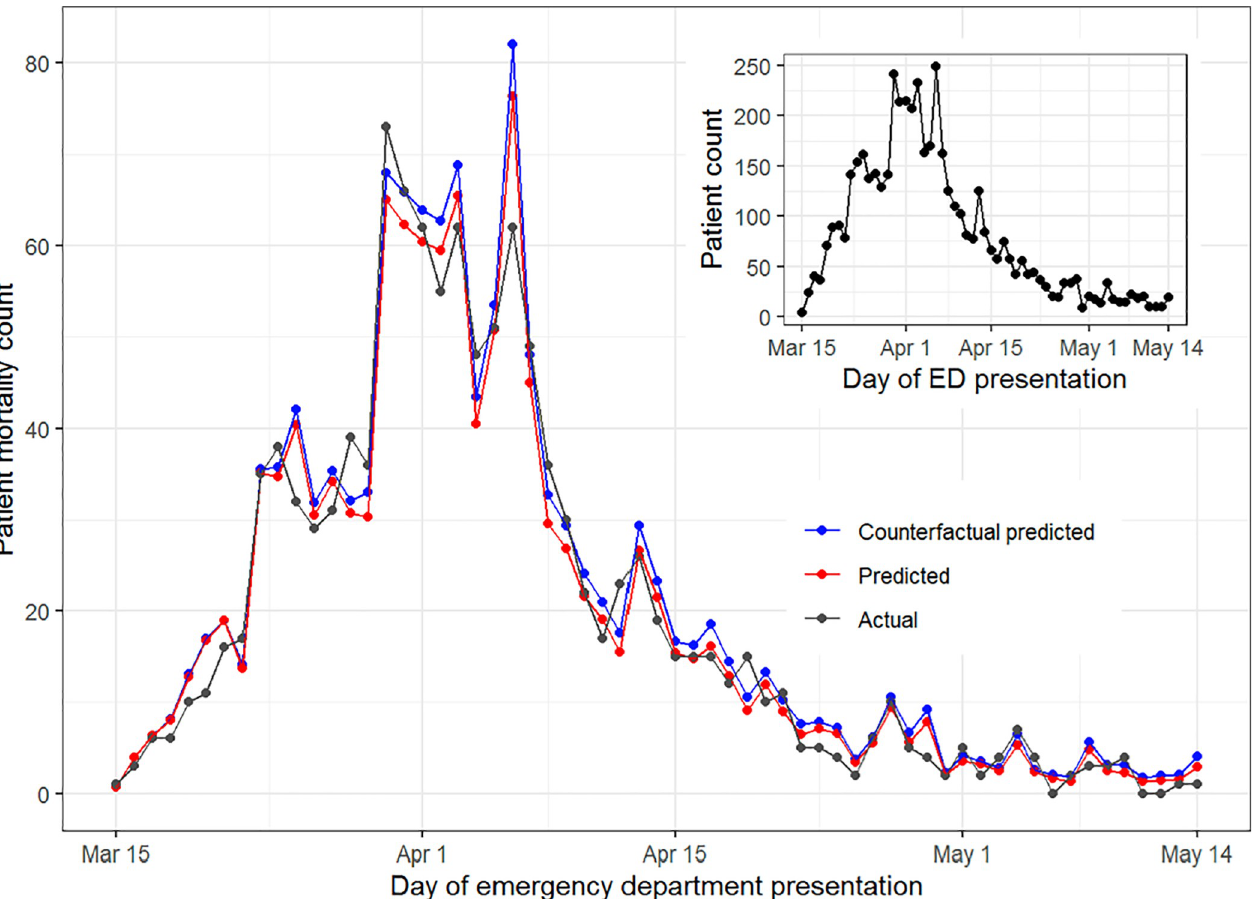
Fig 4. Number of hospitalized patients who died during their hospitalization by day of ED presentation. Black lines represent the actual number of deaths. Red lines represent predicted number of deaths based on the multivariable logistic regression model. Blue lines represent the predicted number of deaths if the proportions of patients with high, medium, and low viral loads had stayed the same as that observed on March 15, 2020. The Hosmer-Lemeshow test had a P value of 0.084 for testing general calibration and an across-time variant had a P value of 0.21. An additional graph in the top-right corner demonstrates the number of patients admitted with COVID-19 to study hospitals during each day of the